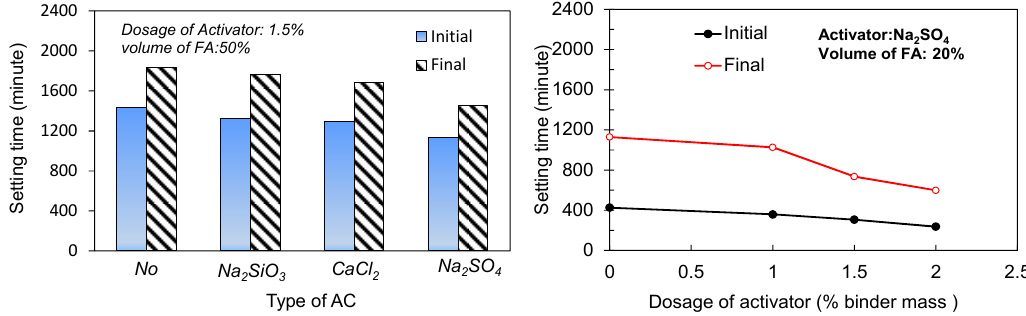
Figure 6. Effect of the type and dosage of AC on the setting time of FACs. FACs, fly ash concretes.